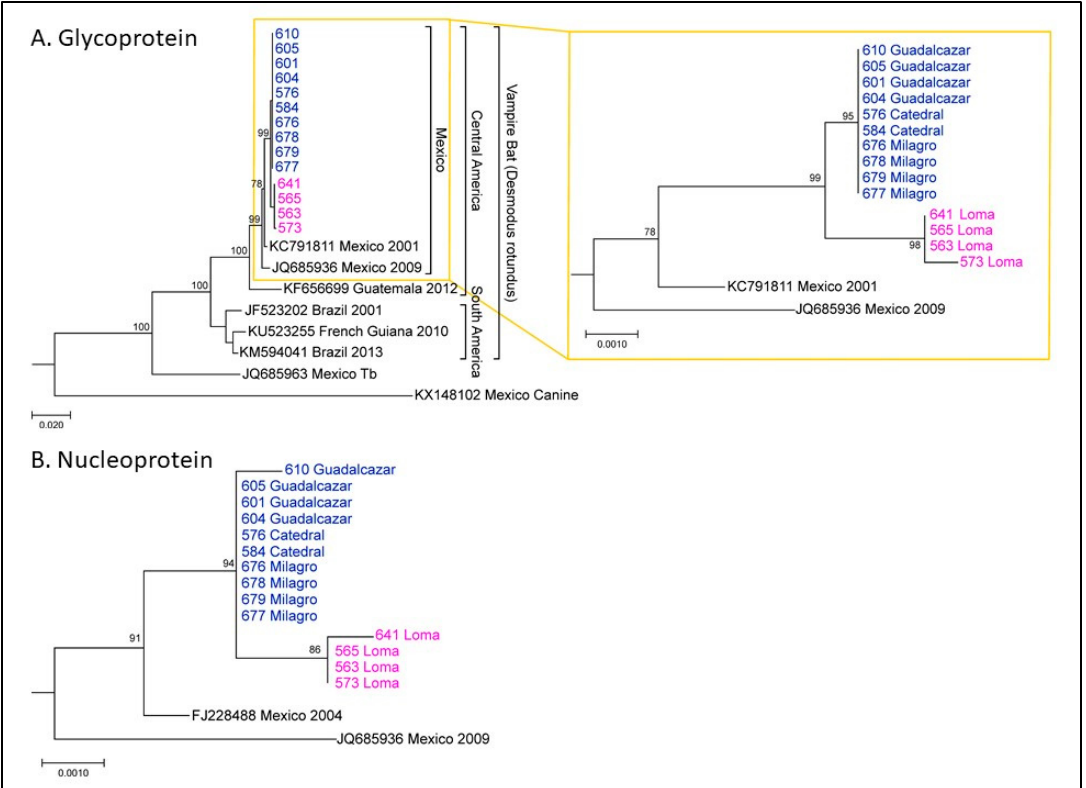
Figure 3. Phylogenetic analysis of glycoprotein ( A ) and nucleoprotein ( B ) nucleotide sequences. Phylogenetic trees were estimated by Maximum Likelihood in Mega7. Newly generated sequences from Mexican Desmodus rotundus (magenta, Group 1 and blue, Group 2) clustered with isolates of RABV circulating in Desmodus rotundus in Mexico (A, left). The yellow box highlighted on the glycoprotein gene tree is enlarged on the right to show more detail. Numbers at branch points indicate bootstrap value (out of 1000 replicates). Scale bars indicate number of changes per site. Reference sequences from RABV strains circulating in vampire bats in M é xico, Guatemala, Brazil, and French Guiana were included; references from RABV isolated from a Mexican free-tailed bat ( Tadarida brasiliensis ) and a dog (historical) were included as outgroups. Reference sequences are labeled with accession number, country, and year of isolation.